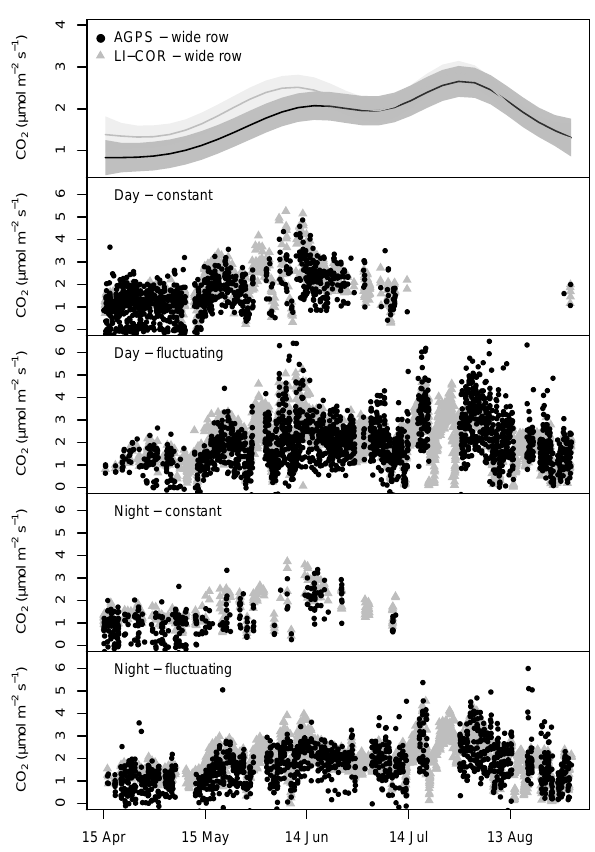
Figure 5. Filtered chamber CO 2 flux data sets for the entire moni- toring period (wide rows only). Modelling and grouping of the data is the same as in Fig. 4 (deviance explained for the GAM: AGPS 71.1%, n = 582; LI-8100A 57.0%, n =